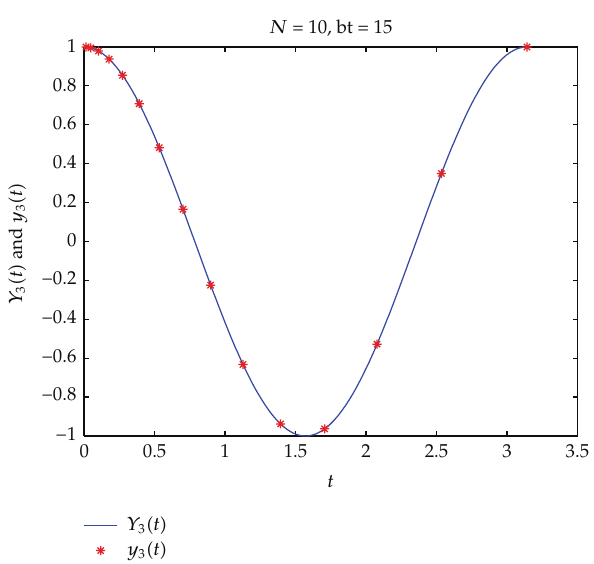
Figure 4: Numerical solution and exact solution.